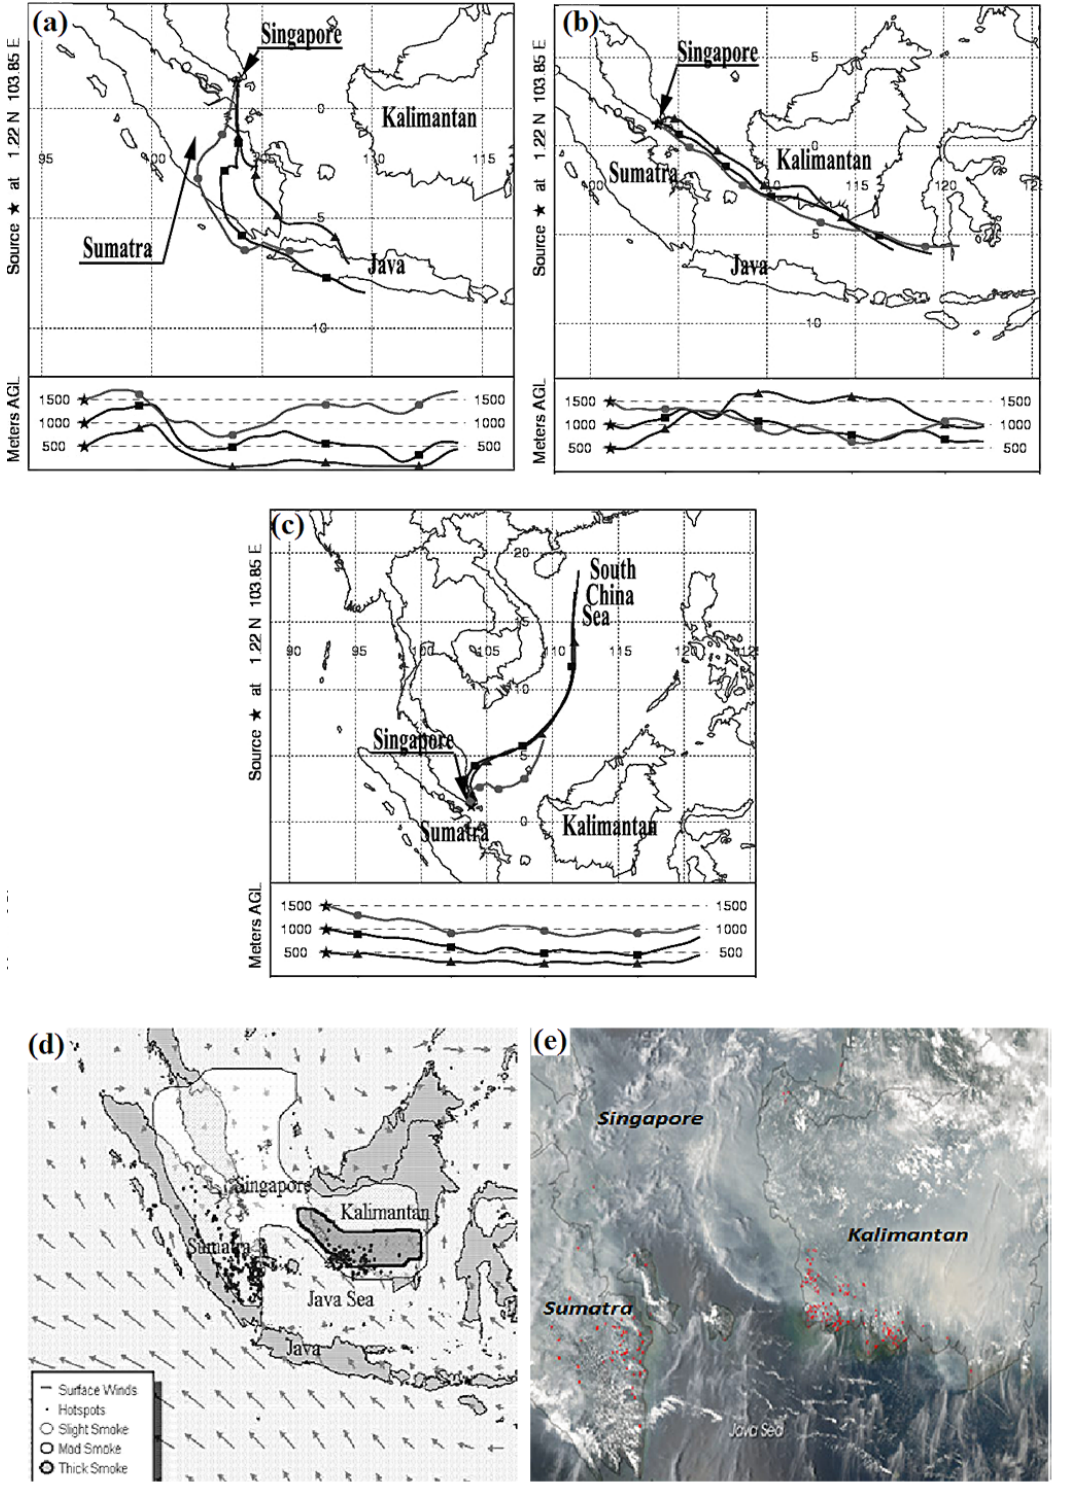
Figure 1. Air mass backward trajectories during haze and clear days in 2006 in Singapore on (a) 7 October 2006; (b) 15 October 2006; (c) 8 January 2007; as well as (d) a haze and fire hotspot map and (e) a satellite image showing smoke due to biomass burning in Sumatra and Kalimantan enveloping the